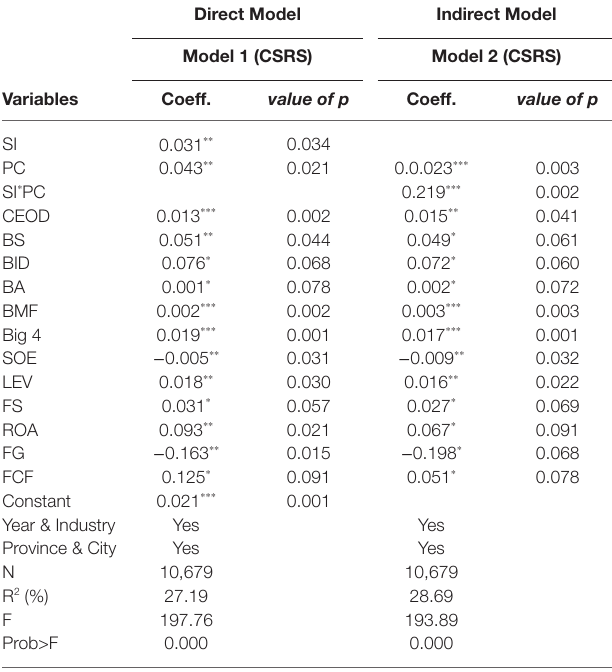
TABLE 4 | Do gender-diverse boards in Chinese firms with PCs affect CSR reporting? Direct Model Indirect Model Model 1